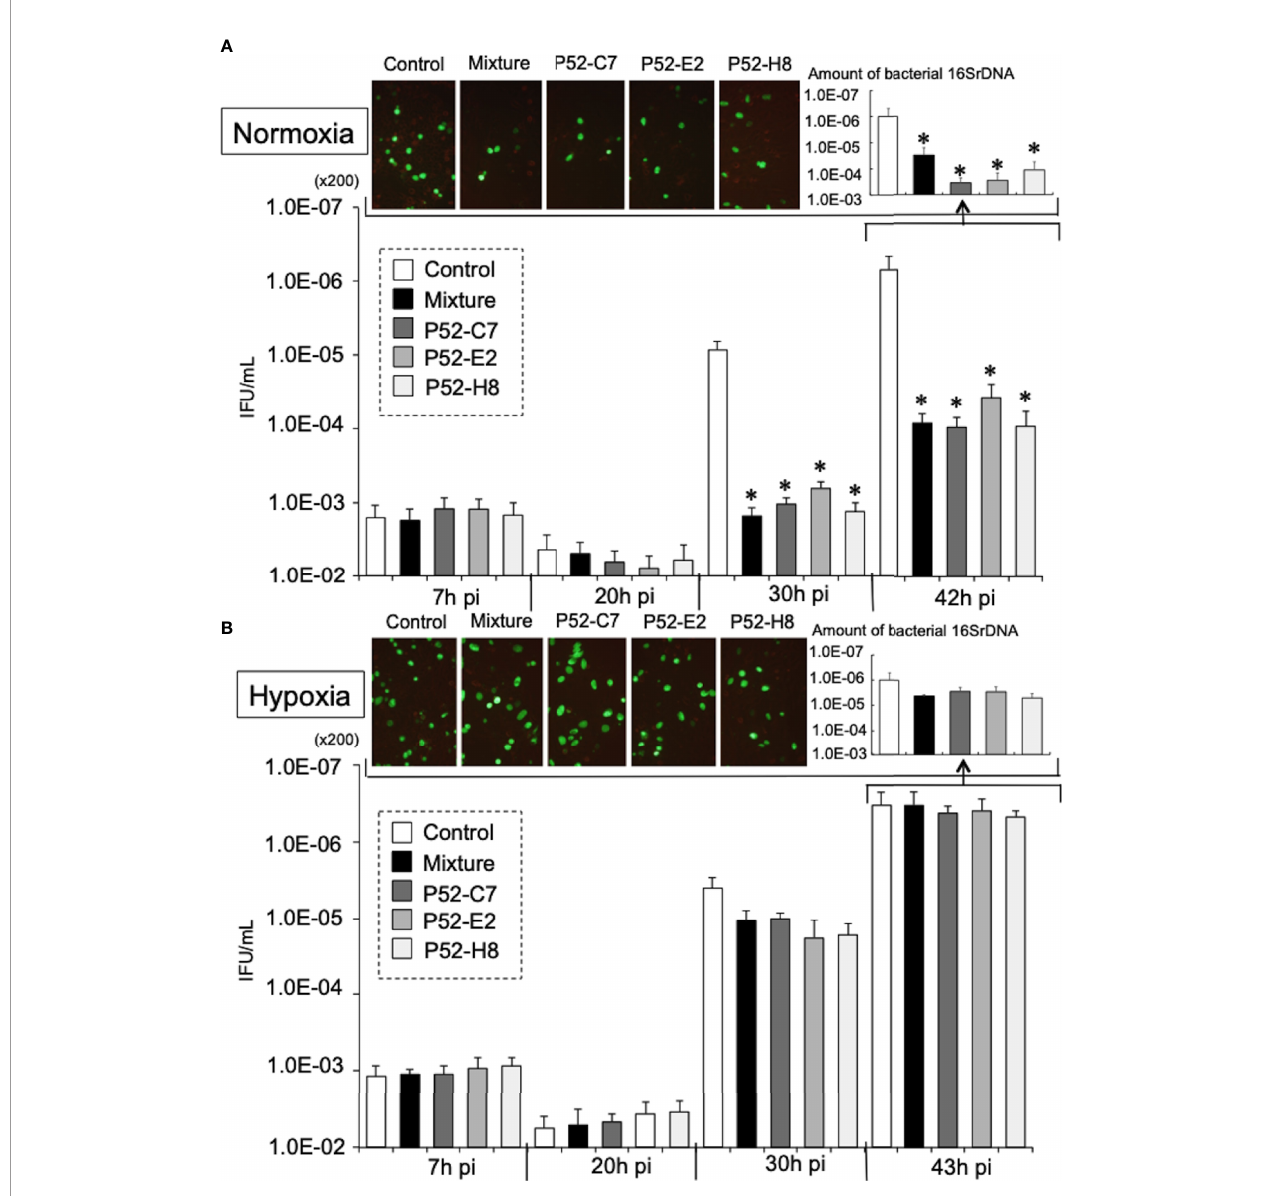
FIGURE 5 | Growth kinetics of GFP-expressing CtL2 (236) in Mt d -HEp-2 (P52-C7, P52-E2, P52-H8) cells and parental HEp-2 cells under normoxia (A) and hypoxia (B) . The cells were infected with GFP-expressing CtL2 (236) at MOI = 5 and then cultured for 48 h under normoxia or hypoxia. Bacterial numbers were determined at 7, 20, 30, and 43 h by IFU assay and qPCR. Magni fi cation for images, ×200. The quantities of chlamydial 16S rDNA were normalized to that of b -actin . Data show the means ± SD obtained from at least three experiments. * p < 0.05 vs. the value of each control (white